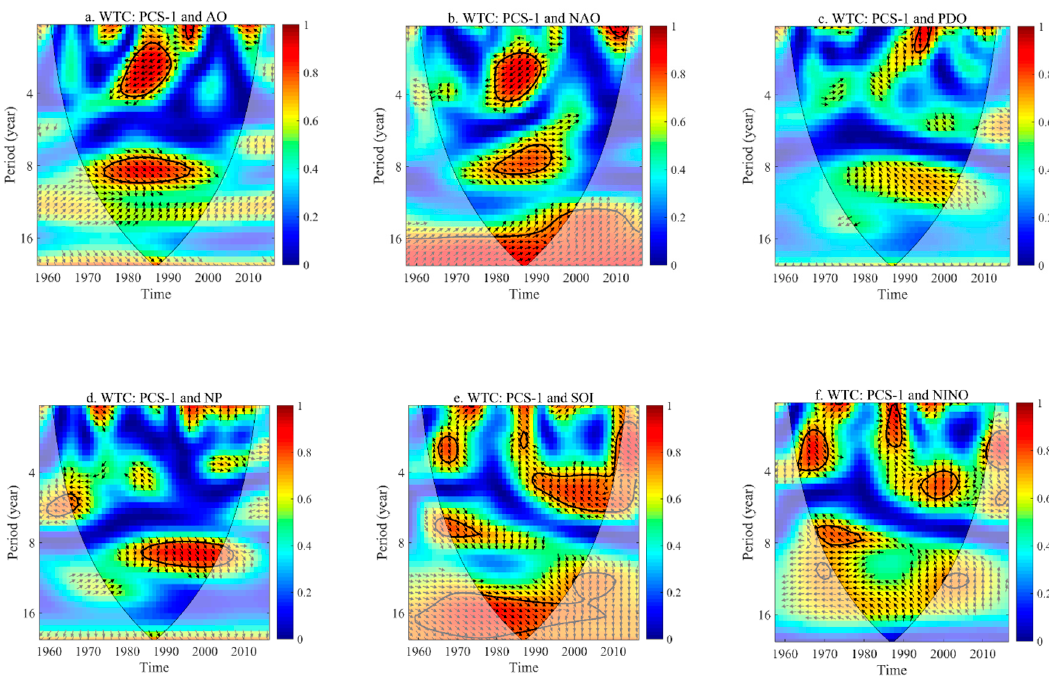
Figure 7. Wavelet coherence spectrum between PCS-1 and climate oscillations ( a – f climate oscillations of AO, NAO, PDO, NP, SOI and NINO, respectively).